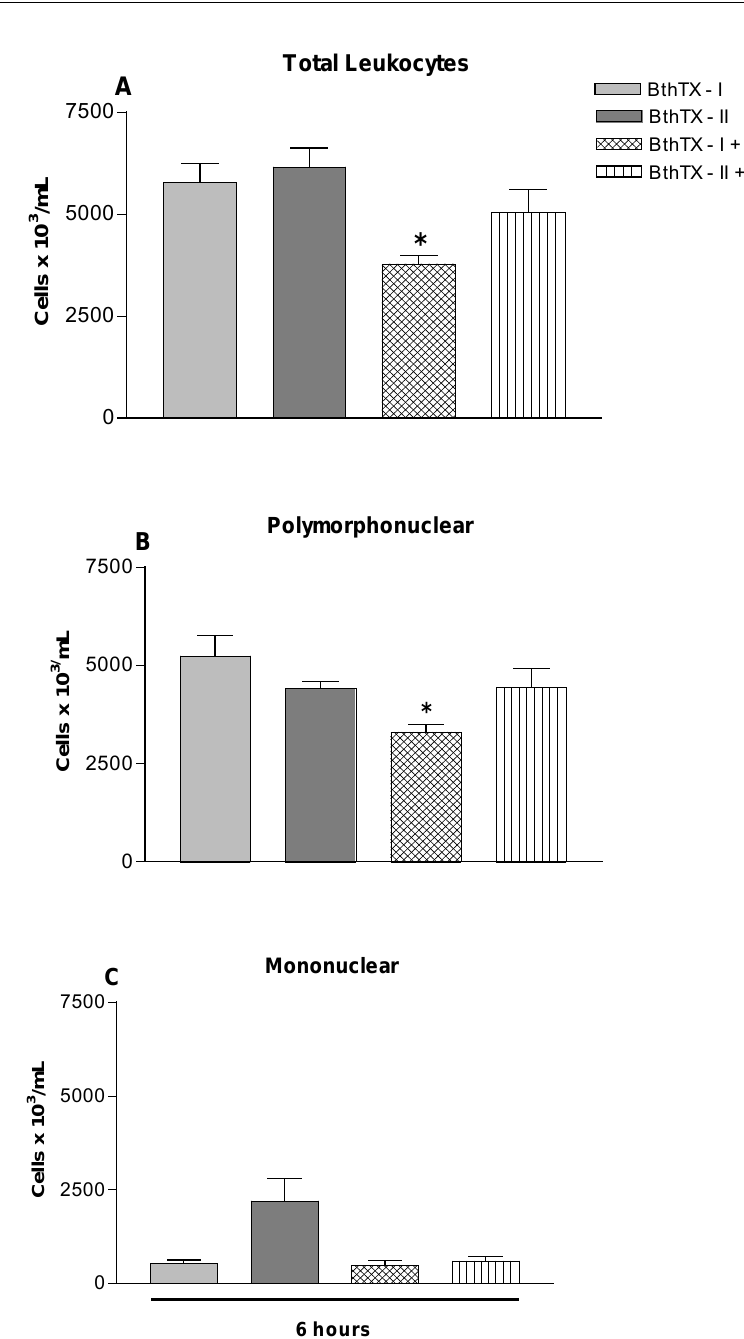
Figure 4. The effect of B. portulacoides ethanolic extract on leukocyte influx into the peritoneal cavity induced by two myotoxins isolated from B. jararacussu venom. Mice were pretreated with the extract (500 mg/kg) one hour before injection of BthTX-I or BthTX-II (0.8 mg/kg of BthTX-I and 0.4 mg/kg of BthTX-II). Mice were killed after six hours and inflammatory exudates were withdrawn after washing the peritoneal cavity. Total leukocytes ( A ), PMN cells ( B ) and MN cells ( C ). Results are presented as mean ± SEM ( n = 5). * p <